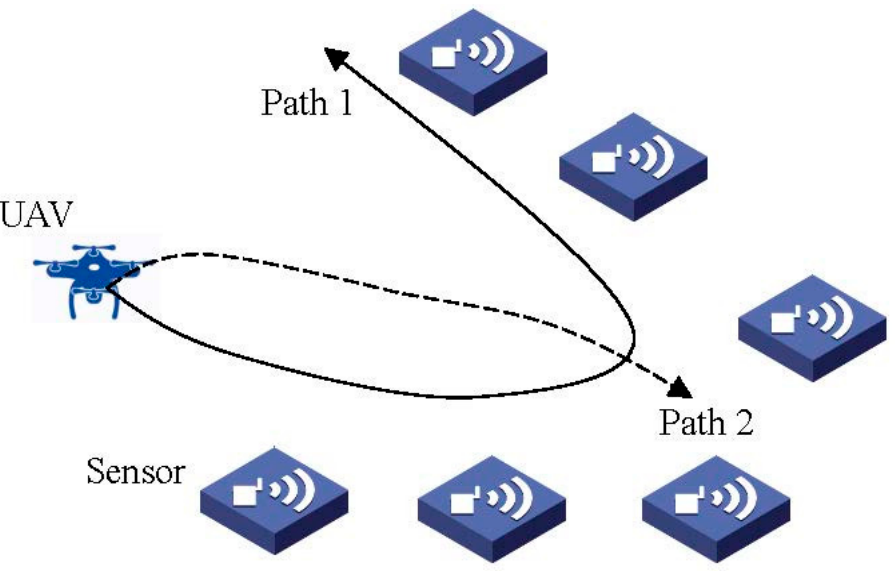
Figure 8. Flight path selection of UAV.